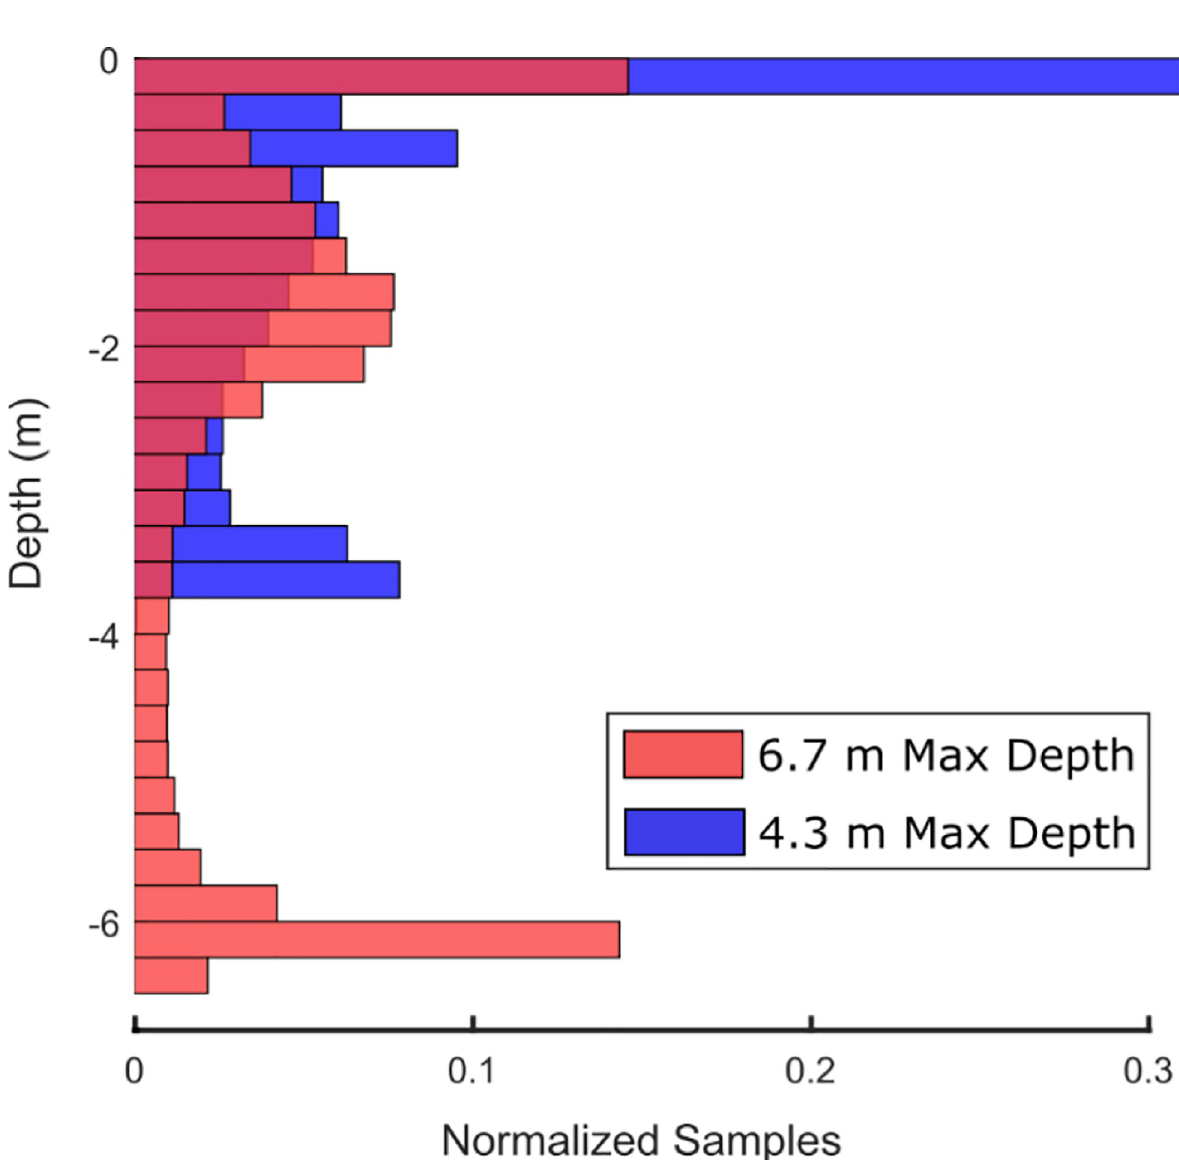
Fig 2. Representative depth data. Representative depth data (also used for Fig 1) taken from an individual animal at a facility with gated environments of different maximum depths. Depth data from one ~3.0 hr recording are shown for the section of the habitat with a maximum depth of 6.7 m in red and the section of the habitat with a maximum depth of 4.3 m in blue. Areas of overlap are indicated by the dark red color. The maximum depths achieved by the dolphin in each region were ~6.5 m and ~3.75 m, respectively. The sample counts for each histogram were normalized by the histogram’s total sample count (summing to 100% of the data) to ensure the comparison was valid.